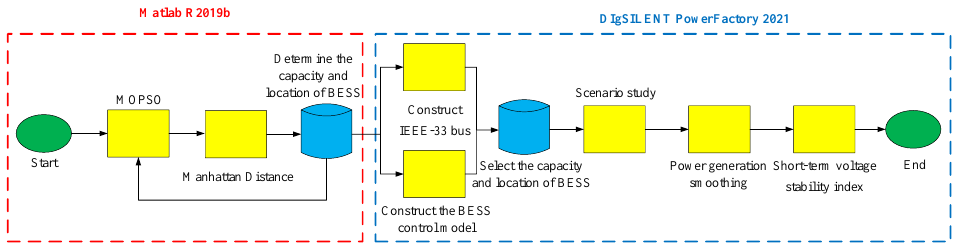
Figure 1. Schematic diagram of the proposed MATLAB and DIgSILENT simulations.